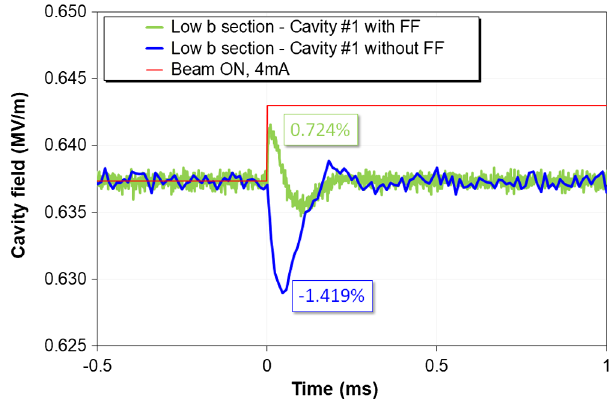
FIG. 13. Residual perturbation on the accelerating field of cavity #1 in the low β section with a 4.1 mA proton beam with and without feedforward (FF).